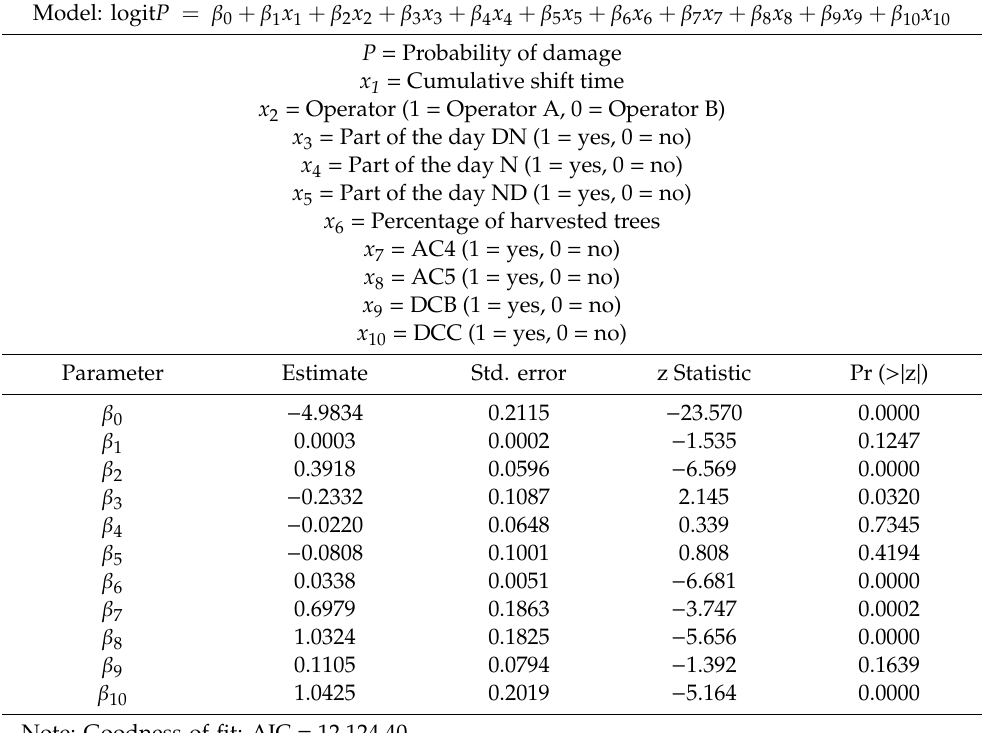
Table 7. Relationships between the probability of damage and model